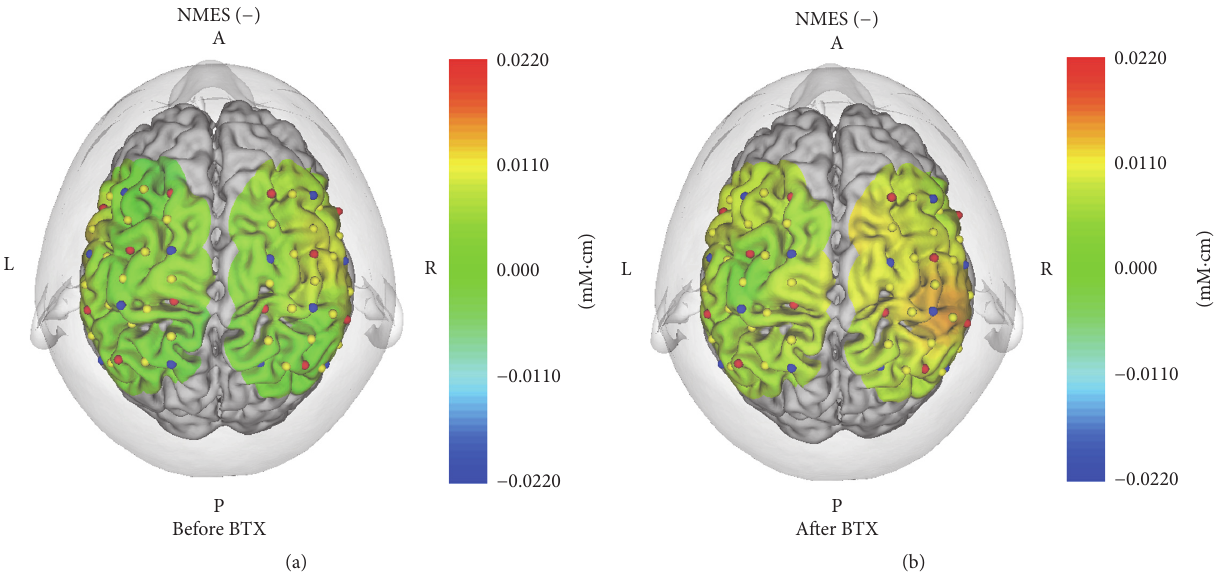
Figure 7: Three-dimensional maps of hemodynamic responses (changes in the oxy-Hb concentration) in the brain while the patient performed finger pinching with the left hand before BTX-A treatment (a) and after BTX-A treatment (b). There was an increase in activation in the ipsilesional SMC after BTX-A treatment compared with that before BTX-A treatment.